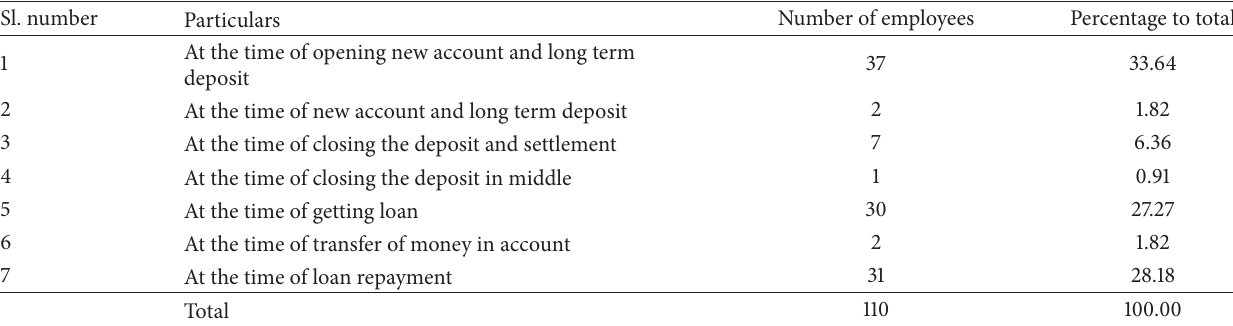
Table 3: At which stage the customers are approaching.